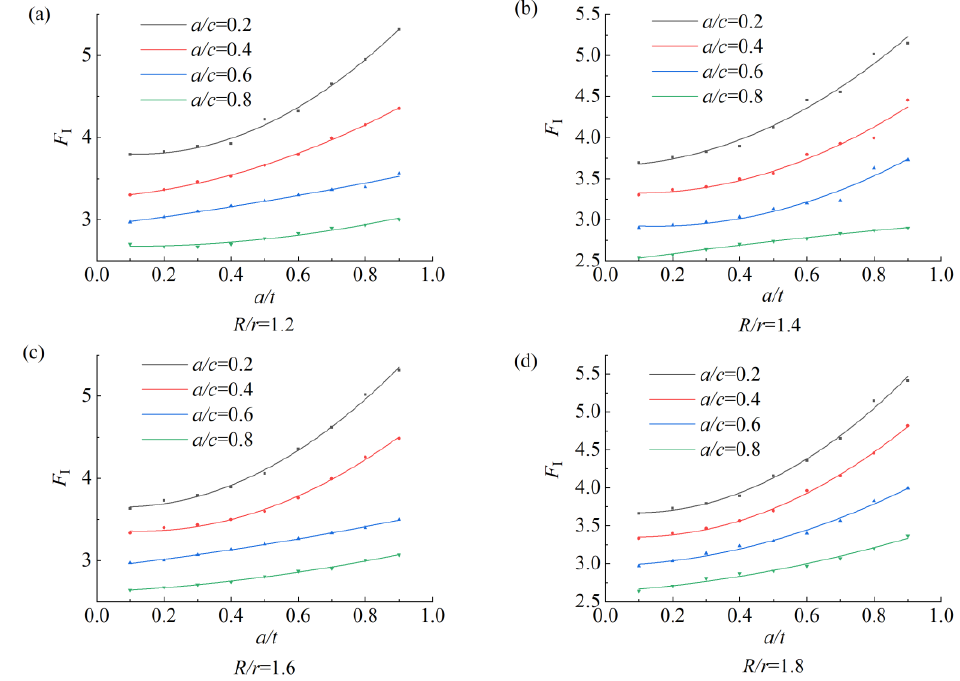
Figure 9. Corrected shape coefficient of type I SIF with a V-shaped notch. ( a ) R / r = 1.2. ( b ) R / r = 1.4. ( c ) R / r = 1.6. ( d ) R / r =1.8.